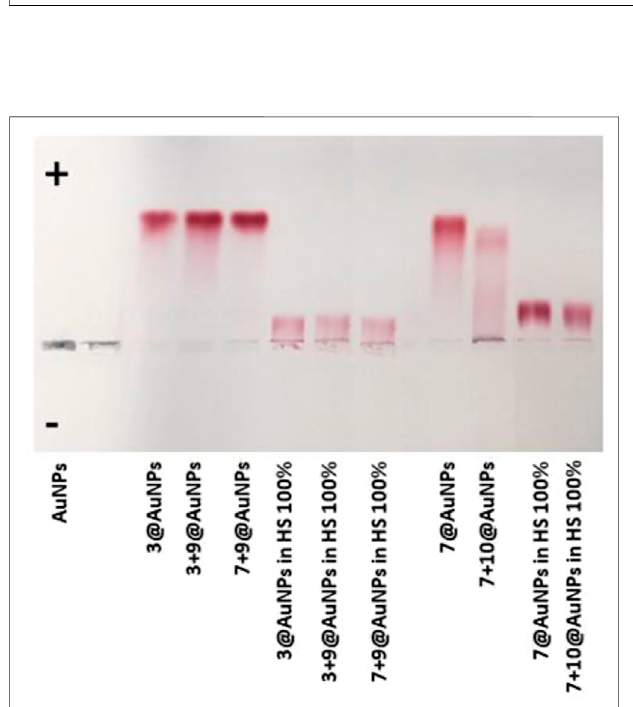
FIGURE 7 | Agarose gel electrophoresis of AuNPs after incubation in water and in 100% HS.